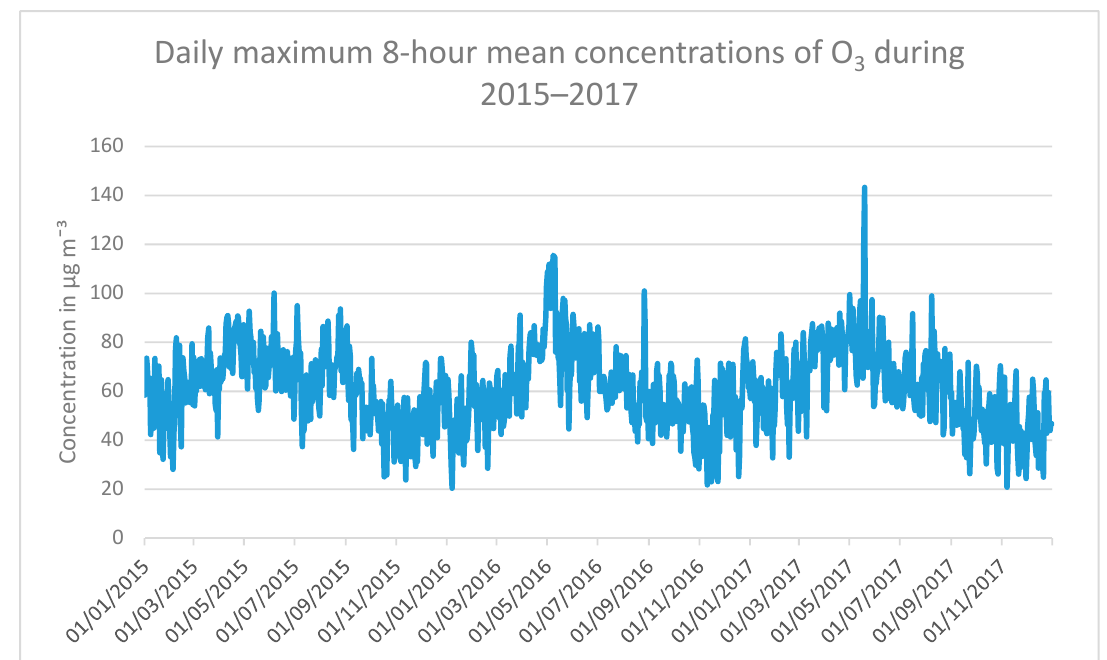
Figure A2. Daily maximum 8-h mean concentrations of O 3 at an urban background station in Stockholm during the period of 2015–2017.